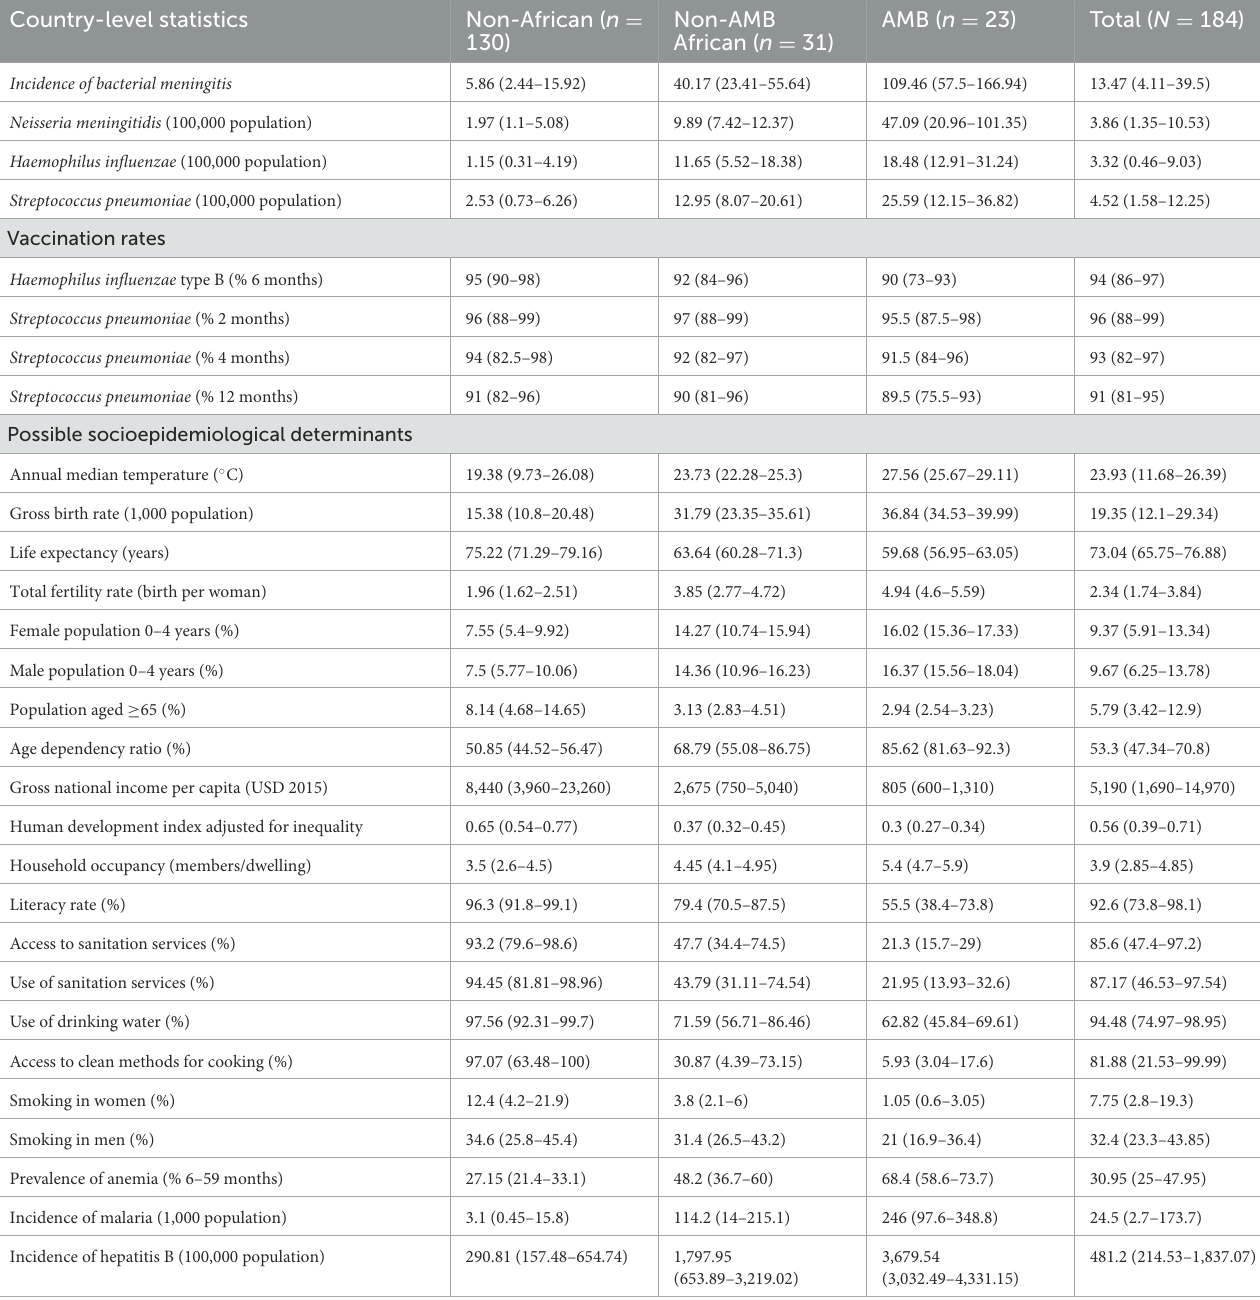
TABLE 1 Country-level statistics per country’s region (outside Africa, inside Africa but not in the AMB, and in the AMB). Country-level